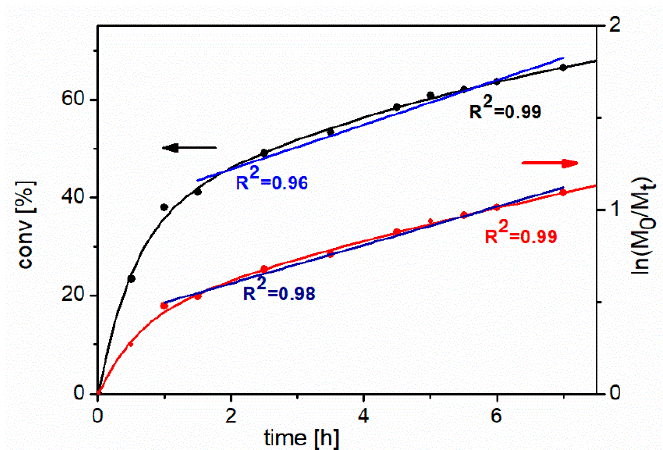
Figure 3. Conversion of monomer vs time and first-order kinetic plot (right axis) for the Atom Transfer Radical Polymerization (ATRP) of NIPAM. Polymerization conditions: [NIPAM]:[NCPAE]:[CuCl]:[Me 6 TREN] = 50:1:1:1, room temperature, isopropanol as a solvent (1:2 NIPAM:solvent, w/w ). The black and red arrows indicate a proper axis for the relationship shown in the same color.